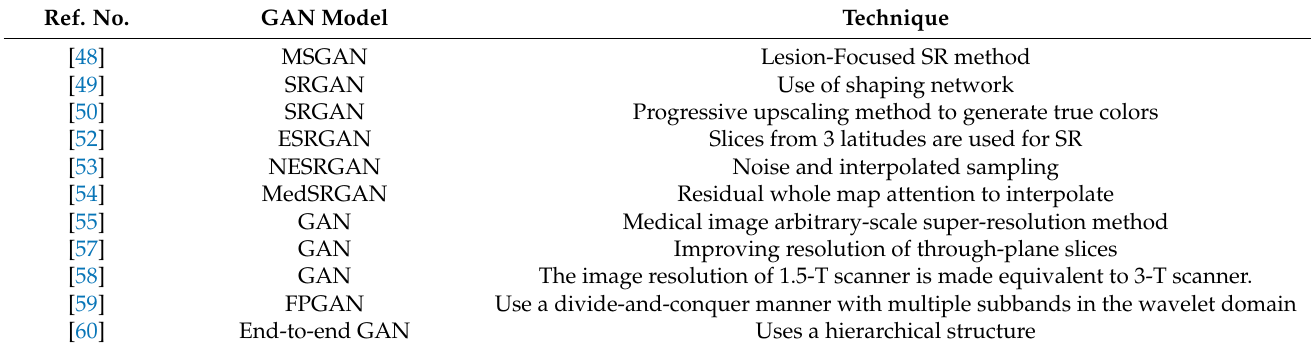
Table 7. Summary of GAN-synthesized images used for super-resolution. Ref. No.